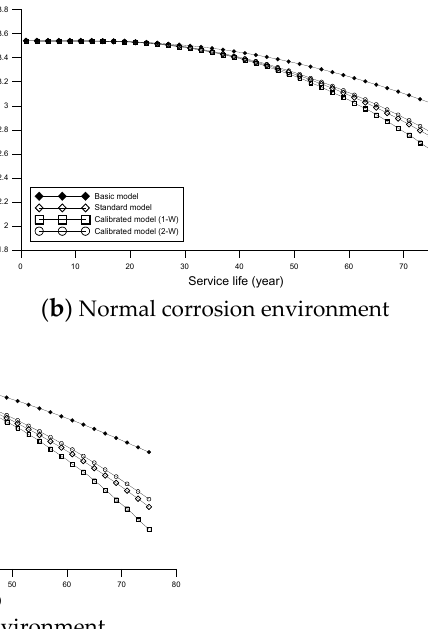
Figure 8. Reliability degradation under light traffic characteristics (with previous inspection).